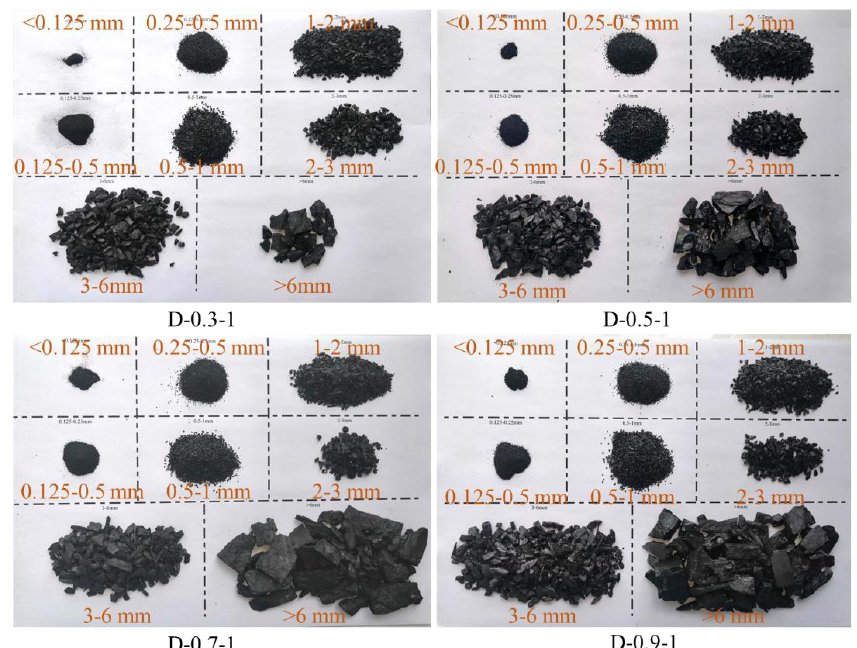
Figure 6. Coal fragment morphology with different l / d under dynamic loading.